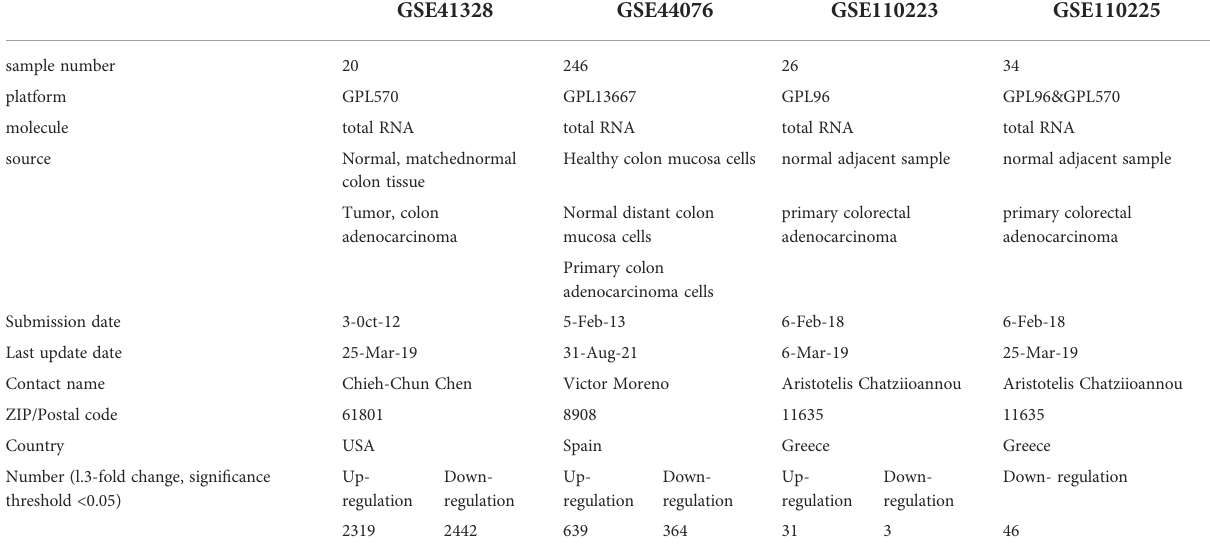
TABLE 1 Number of differentially expressed genes and background in the four data